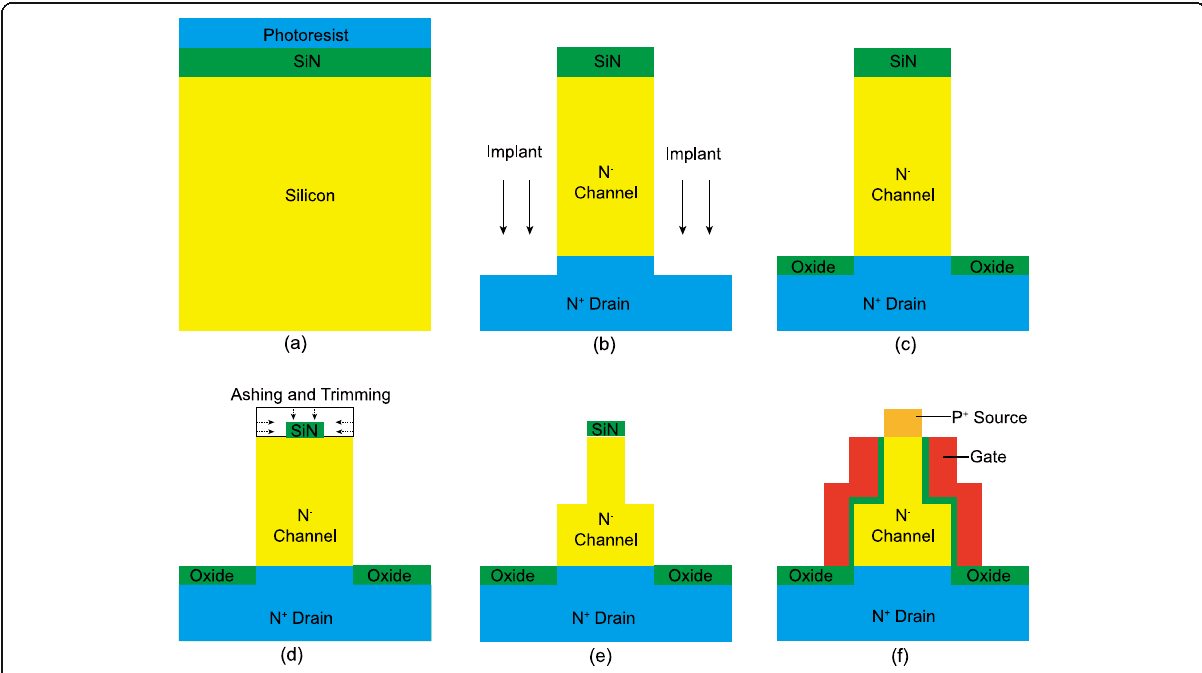
Fig. 8 Fabrication process of the SC TFET. a Silicon substrate preparation with SiN and photoresist deposition. b Etching, implantation, and annealing. c Isolation oxide deposition. d Reducing the thickness and width of SiN by ashing and trimming. e The step channel thickness is introduced. f Gate oxide forming, gate deposition, gate planarization, and source region